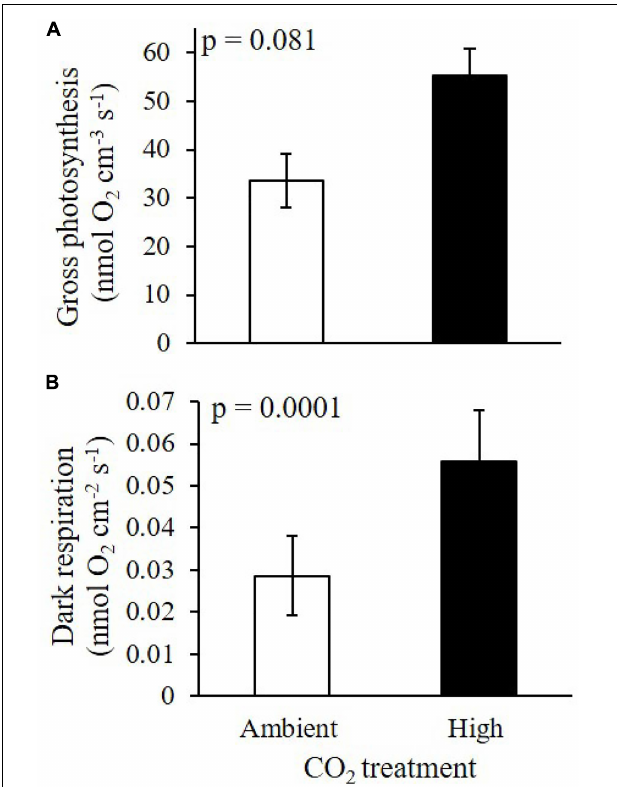
FIGURE 4 | Effects of elevated CO 2 on (A) surface gross photosynthesis, and (B) dark respiration of 10-day-old CCA recruits under two treatments: ambient CO 2 (CO 2 between 400.8 and 448.1 µ atm, pH 8.0–8.03) and high CO 2 (CO 2 between 998.9 and 1070.6 µ atm, pH 7.67–7.70). Gross photosynthesis was measured at the CCA surface at a photon irradiance of 340 µ mol photons m − 2 s − 1 . Data on panel (A) are means ± SE ( n = 3 for ambient CO 2 and n = 2 for high CO 2 ; biological replicates). Data on panel (B) are means ± SE ( n = 9 for each CO 2 treatment).